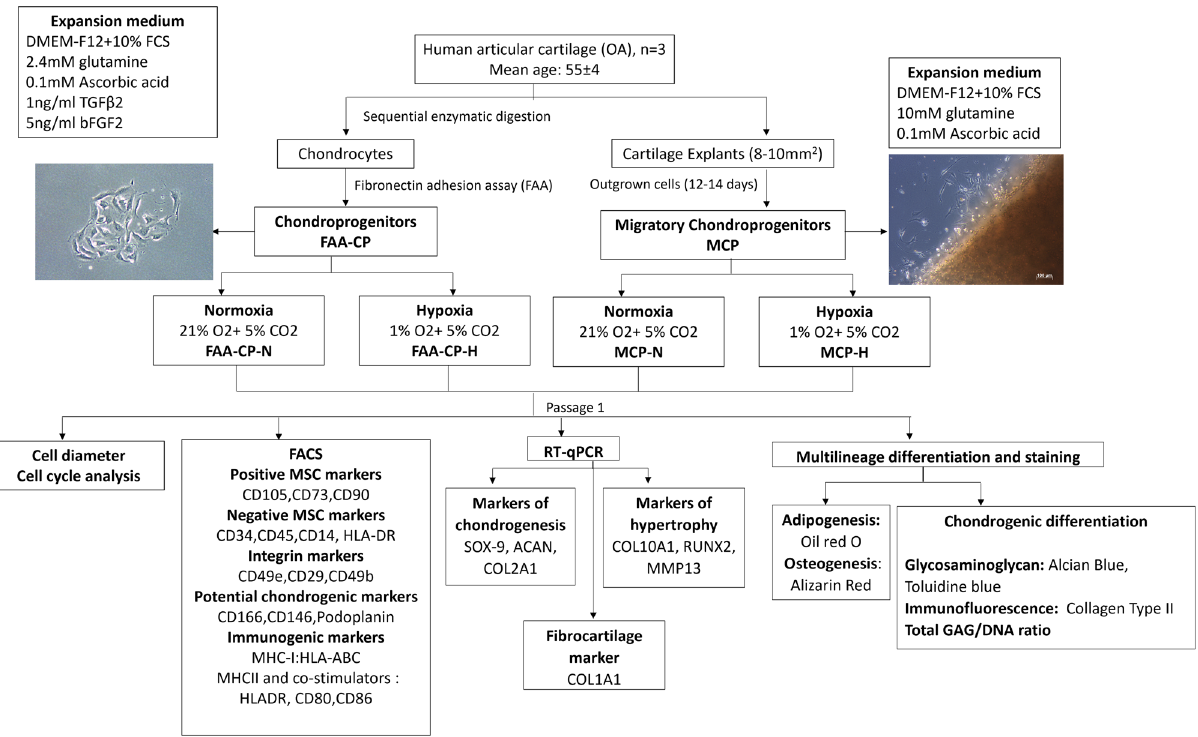
Figure 1. Study algorithm depicting the four groups used for comparison and their evaluation parameters. The four groups were fibronectin adhesion assay-derived chondroprogenitors cultured under normoxia (FAA-CP-N) and hypoxia (FAA-CP-H), migratory chondroprogenitors cultured under normoxia (MCP-N), and hypoxia (MCP-H). OA: osteoarthritis, CD: cluster of differentiation, SOX-9:(sex-determining region Y)-box 9, ACAN: aggrecan, COL: collagen, RUNX2: Runt-related transcription factor-2, MMP-13: matrix metalloproteinase-13, GAG: glycosaminoglycans. The experiments were conducted with three biological samples (n =